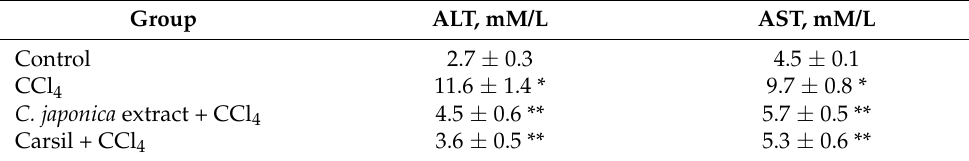
Table 7. Effect of C. japonica extract on CCl 4 induced elevation in AST and ALT levels.